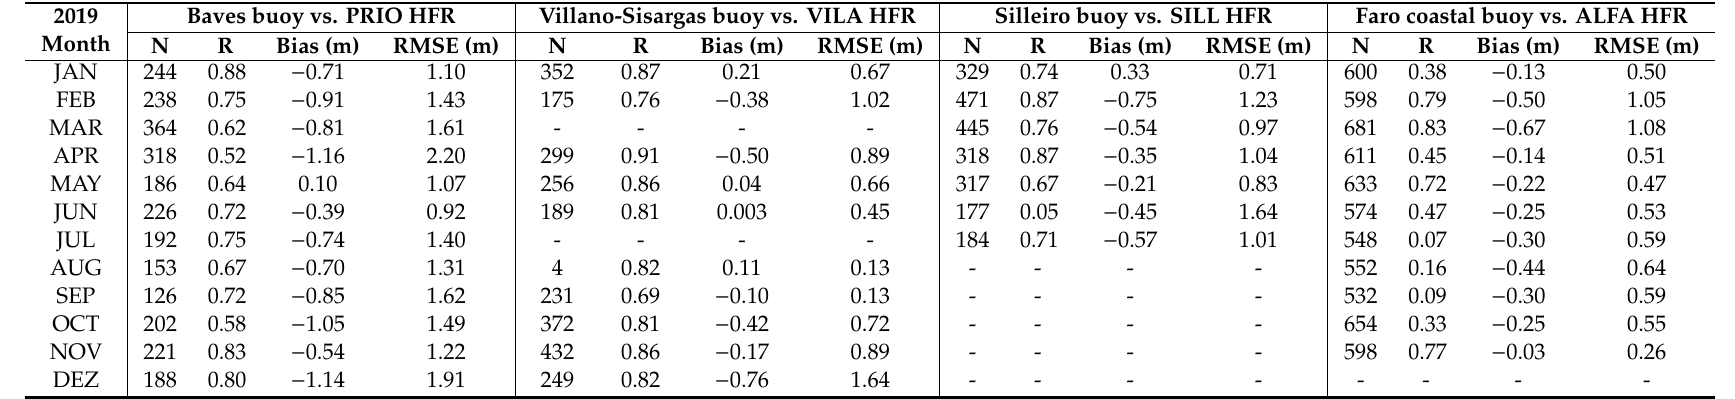
Table A3. Monthly statistics for the SWH comparison between buoys and HFR sites during 2019. Statistics metrics: Correlation coe ffi cient (R), RMSE and bias. N corresponds to HFR & buoy paired hourly observation. Statistics presented for the four pairs buoy-HFR (Baves vs. PRIO; Villano-Sisargas vs. VILA; Silleiro vs. SILL and Faro coastal vs.